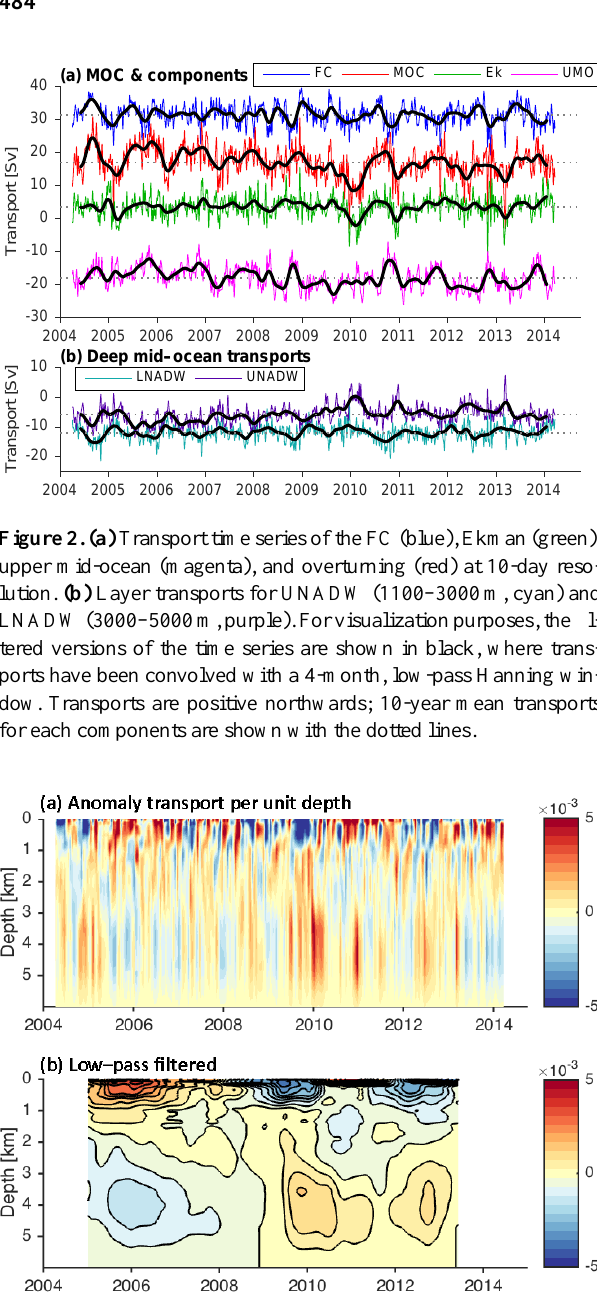
Figure 3. Transport-per-unit-depth anomalies of the mid-ocean transport at 26 ◦ N, where the time-mean profile over the 10 years has been removed. (a) The top panel shows the twice-monthly, de- seasonalized variability and (b) the lower panel is further filtered with the 1.5year filter. Red (blue) shows transports that are anoma- lously northward (southward).